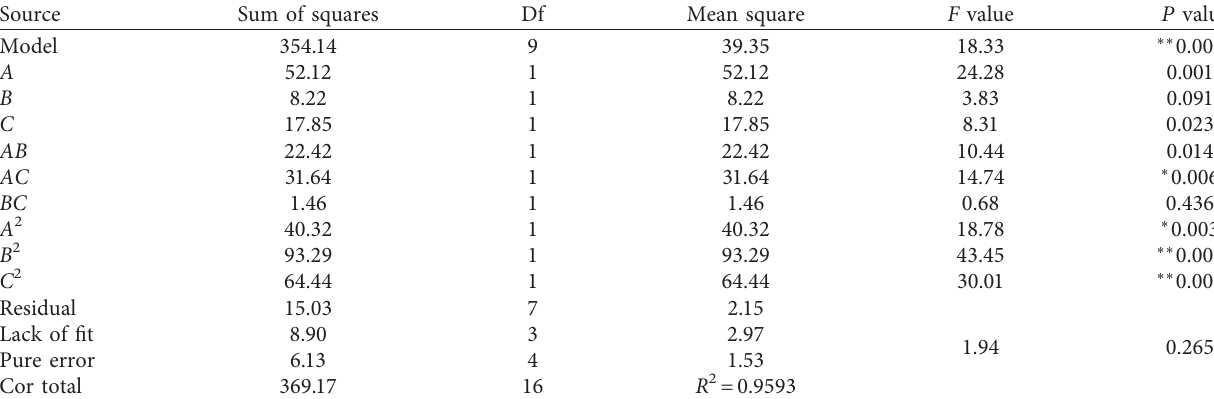
Table 4: Analysis of variance.